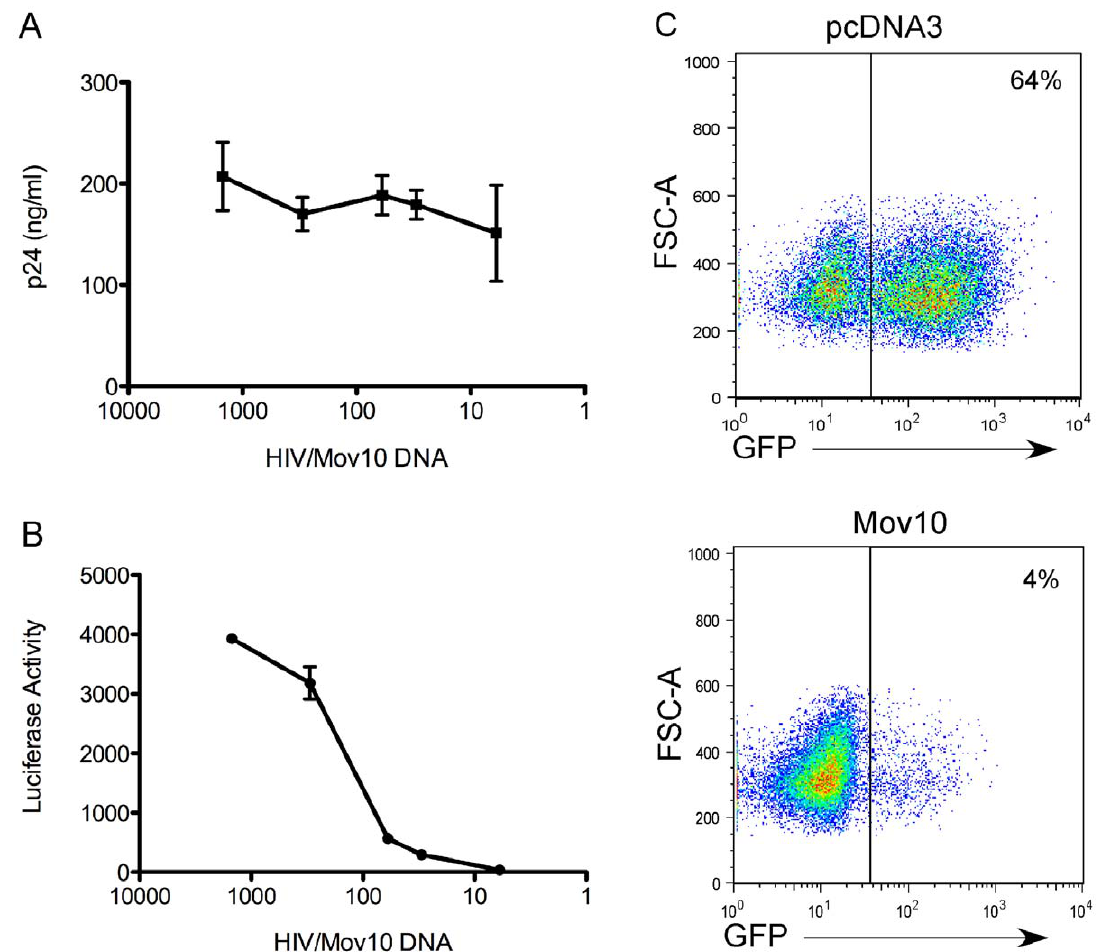
Figure 2. Mov10 decreases specific infectivity of HIV-1. Supernatants of 293T cells that had been transfected with varying amounts of Mov10- expressing plasmid were assayed for ( A ) HIV-1.Luc p24 levels and ( B ) after standardization by p24 content, infectivity of target cells was determined by luciferase activity from VSVG.HIV.Luc, which encodes all the HIV accessory genes. For simplicity, the amount of Mov10 plasmid that was transfected is expressed as a ratio of HIV-1 plasmid to Mov10 plasmid and plotted logarithmically. In the experiment (see Materials and Methods for further explanation) HIV-1 plasmid levels remained constant, while Mov10 plasmid was used at levels of 1/6 to 1/1500 that of the HIV-1 plasmid. Error bars represent one standard deviation. ( C ) Representative plots of Jurkat T cells infected with GFP-expressing virus produced in the presence of either pcDNA3 or Mov10 (ratio of Mov10 to HIV-1 plasmid was 1/25) three days after infection. Quantification of experiments performed using GFP- expressing virus is shown in supplemental figure